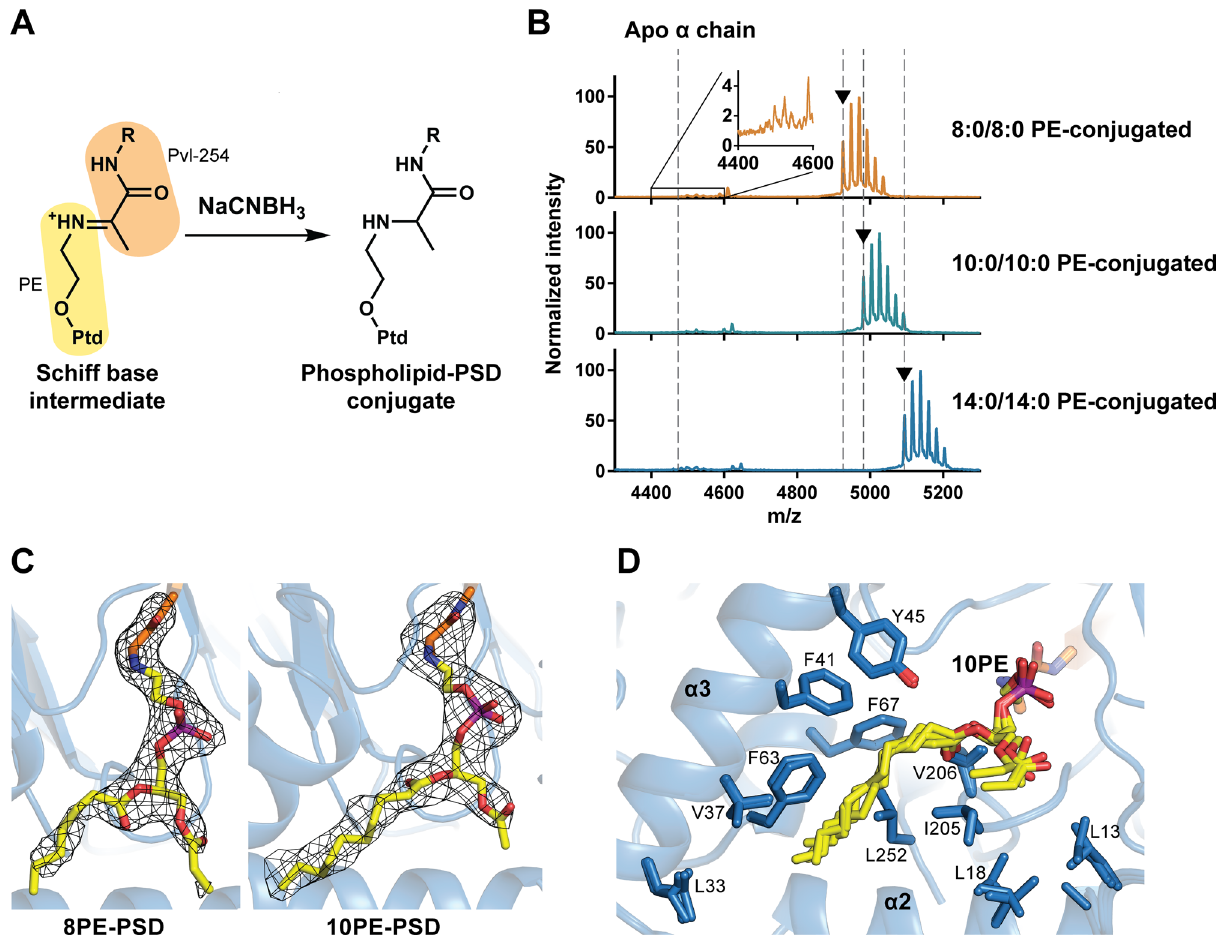
Figure 4. Phospholipid-bound structures. ( A ) A scheme of NaCNBH 3 -dependent reduction of Schiff base. Ptd, phosphatidyl moiety ( B ) MALDI-ToF analysis of phospholipid conjugation on α-chain. The MS peaks of apo and modified α-chains are marked as gray dashed lines and black arrows for comparison of the m/z values. Observed and calculated m/z values of conjugates are 4925.6, 4926.6 (8:0/8:0 PE-conjugated), 4981.8, 4980.7 (10:0/10:0 PE-conjugated), and 5093.8, 5092.8 (14:0/14:0 PE-conjugated), respectively. ( C ) A zoomed-in view of linked phospholipid from 8PE-PSD (Left) and 10PE-PSD (Right). A Fo–Fc omit map of the phospholipid is illustrated as mesh contoured at 2.5 σ. Carbon atoms of the lipid are displayed in yellow, oxygen in red, nitrogen in blue, and phosphorous in purple. ( D ) Overlay of the acyl-chains of bound lipid in the hydrophobic pocket from all four subunits of 10PE-PSD structure. Hydrophobic residues surrounding the acyl-chains are labeled and highlighted as light blue